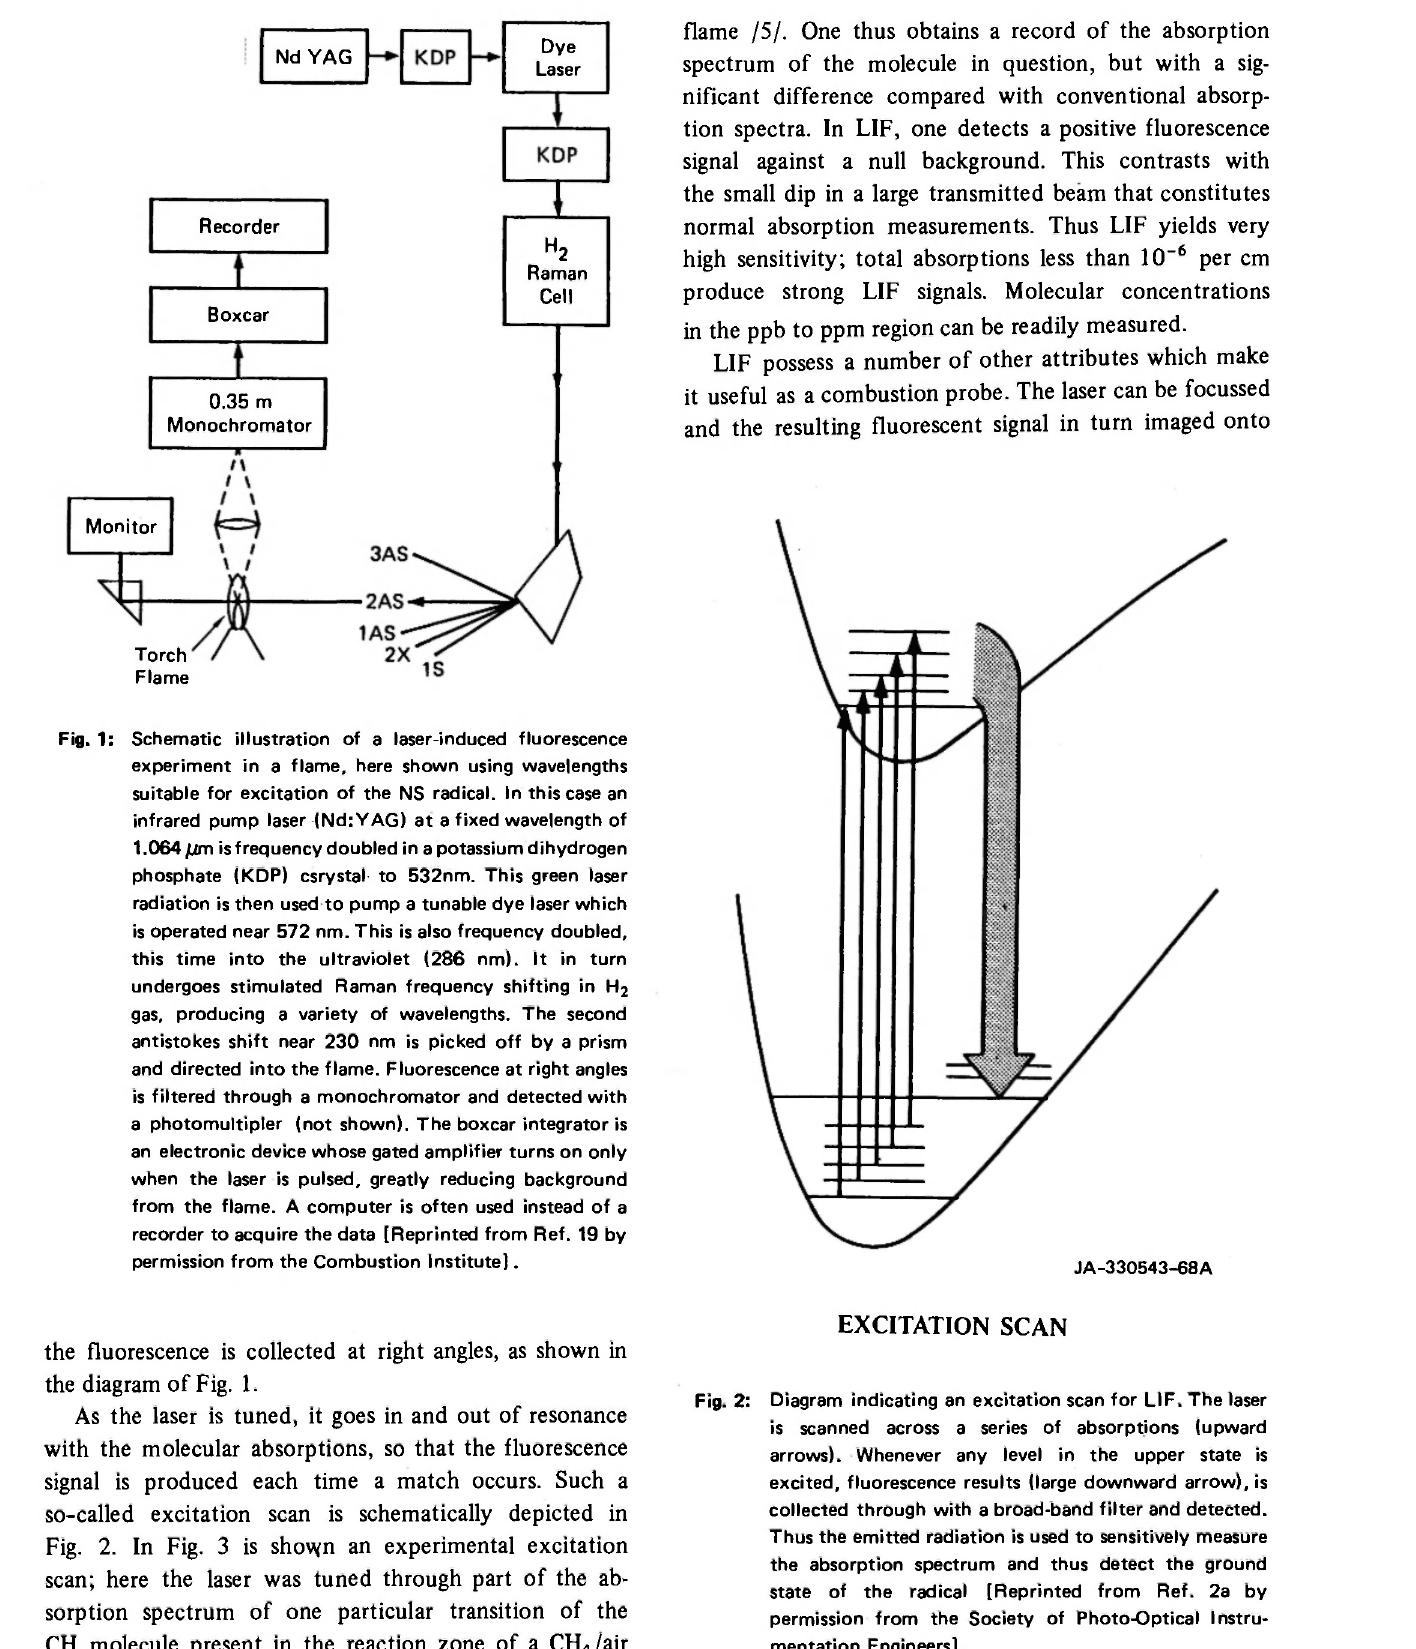
Fig. 2: Diagram indicating an excitation scan for LIF. The laser is scanned across a series of absorptions (upward arrows). Whenever any level in the upper state is excited, fluorescence results (large downward arrow), is collected through with a broad-band filter and detected. Thus the emitted radiation is used to sensitively measure the absorption spectrum and thus detect the ground state of the radical [Reprinted from Ref. 2a by permission from the Society of Photo-Optical Instru- mentation